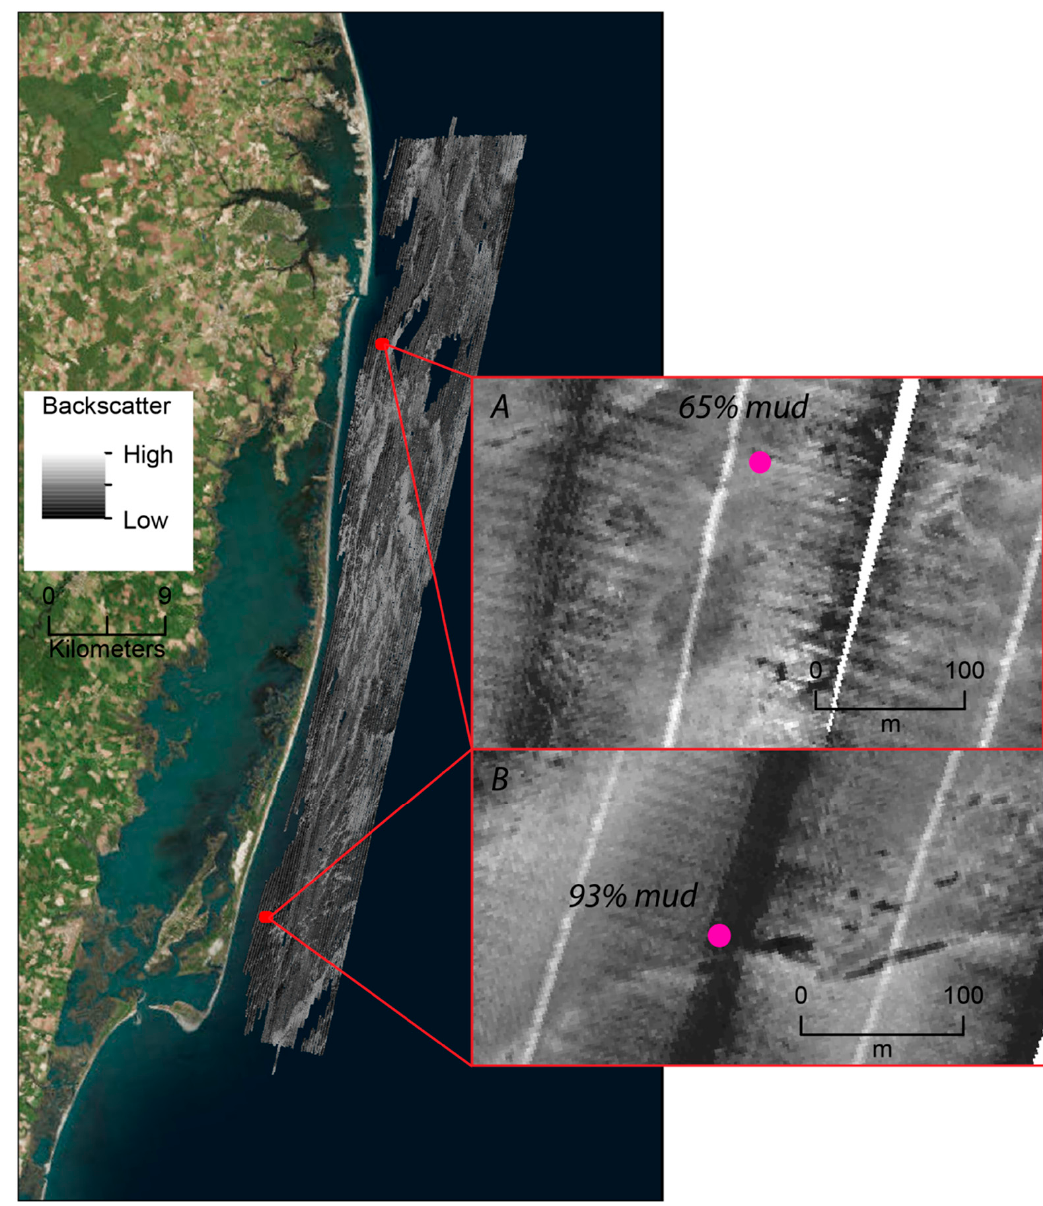
Figure 10. Map of the USGS backscatter imagery acquired in 2014. Inset ( A ) and ( B ) show detailed maps of sample locations (pink dot) collected within a sub-circular feature ( A ) and a linear feature ( B ) in the backscatter data at 2 mpp resolution. Linear and sub-circular pits or features observed on the seafloor in geophysical data often have a finer sediment texture than the surrounding seafloor and occur where finer grained material is cropping out at the seafloor. These features often are not representative of sediment texture adjacent to the feature.